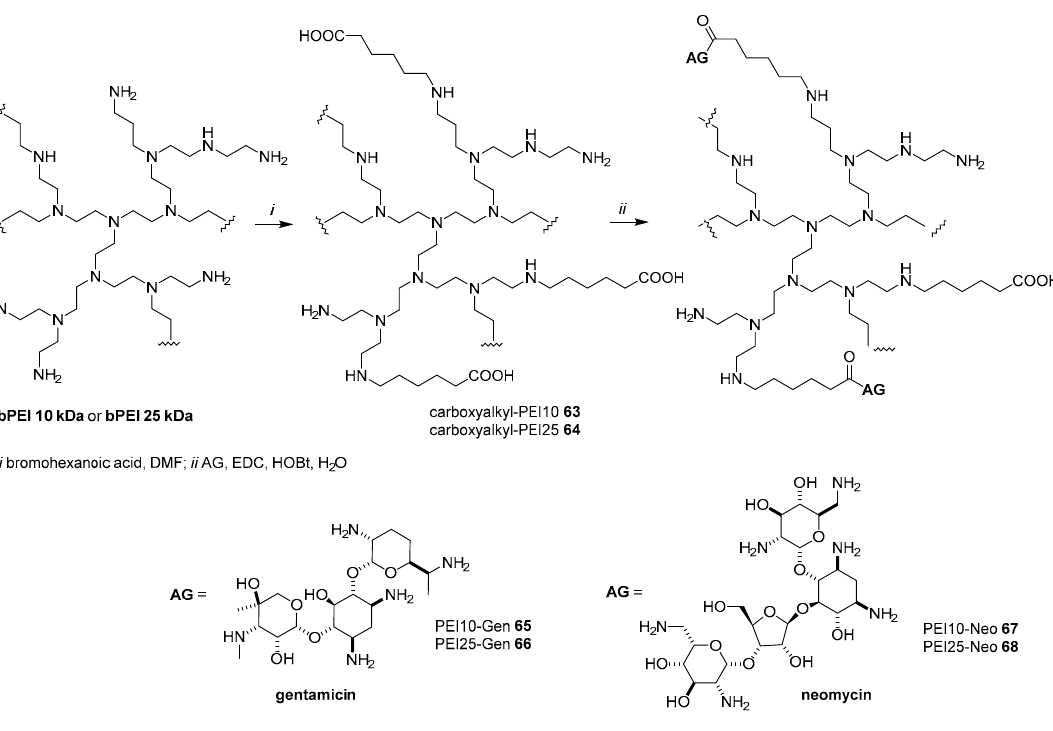
Figure 18. Synthesis of AG-PEI conjugates 65 – 68 .